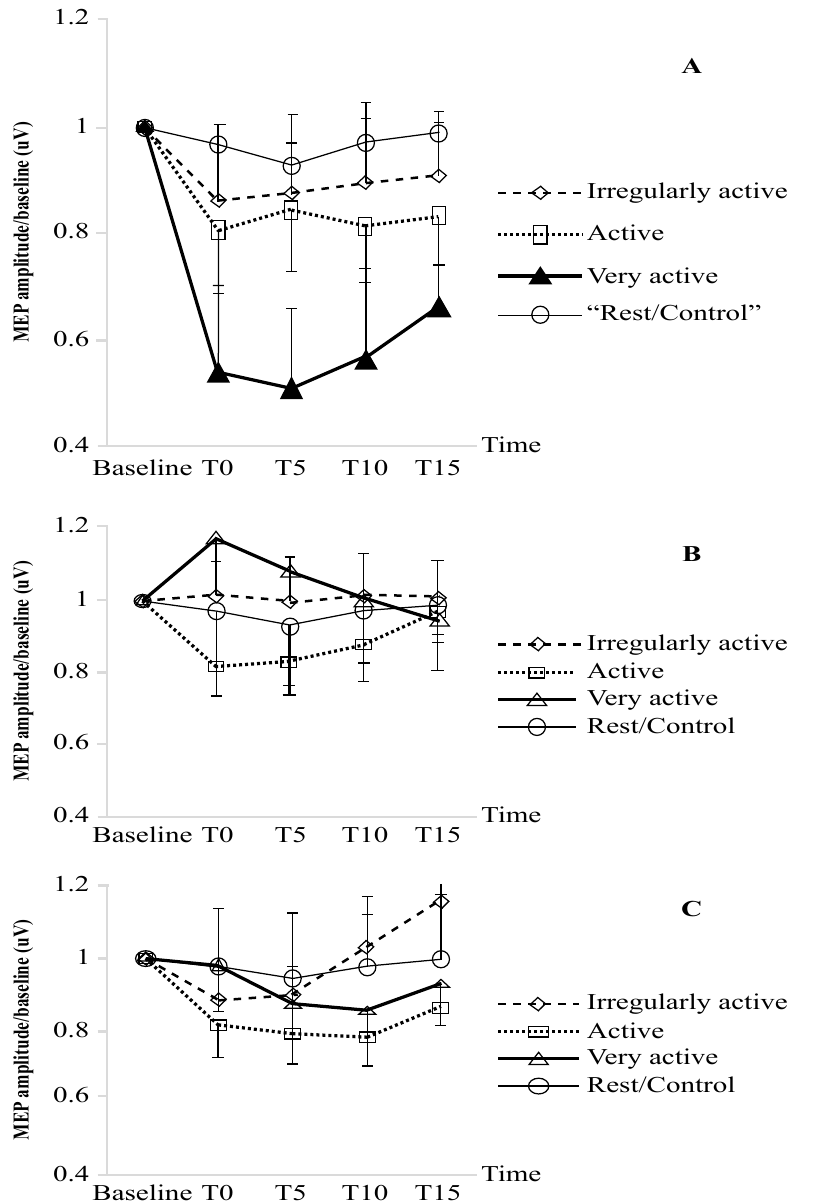
Figure 3. Intensity-dependent effects of physical exercise on corticospinal excitability are depend on the physical activity level of subjects. The time course plots show the effect of different intensities of exercise, high-intensity (3A), moderate-intensity (3B) and low-intensity (3C). Shown are the mean (±SE) of baseline-standardized motor evoked potential (MEP) amplitudes before (baseline) and after (0, 5, 10 e 15 min) exercise/rest condition. Filled symbols indicate significant deviations of the post-exercise/rest MEP amplitudes from baseline values; *significant deviations of rest